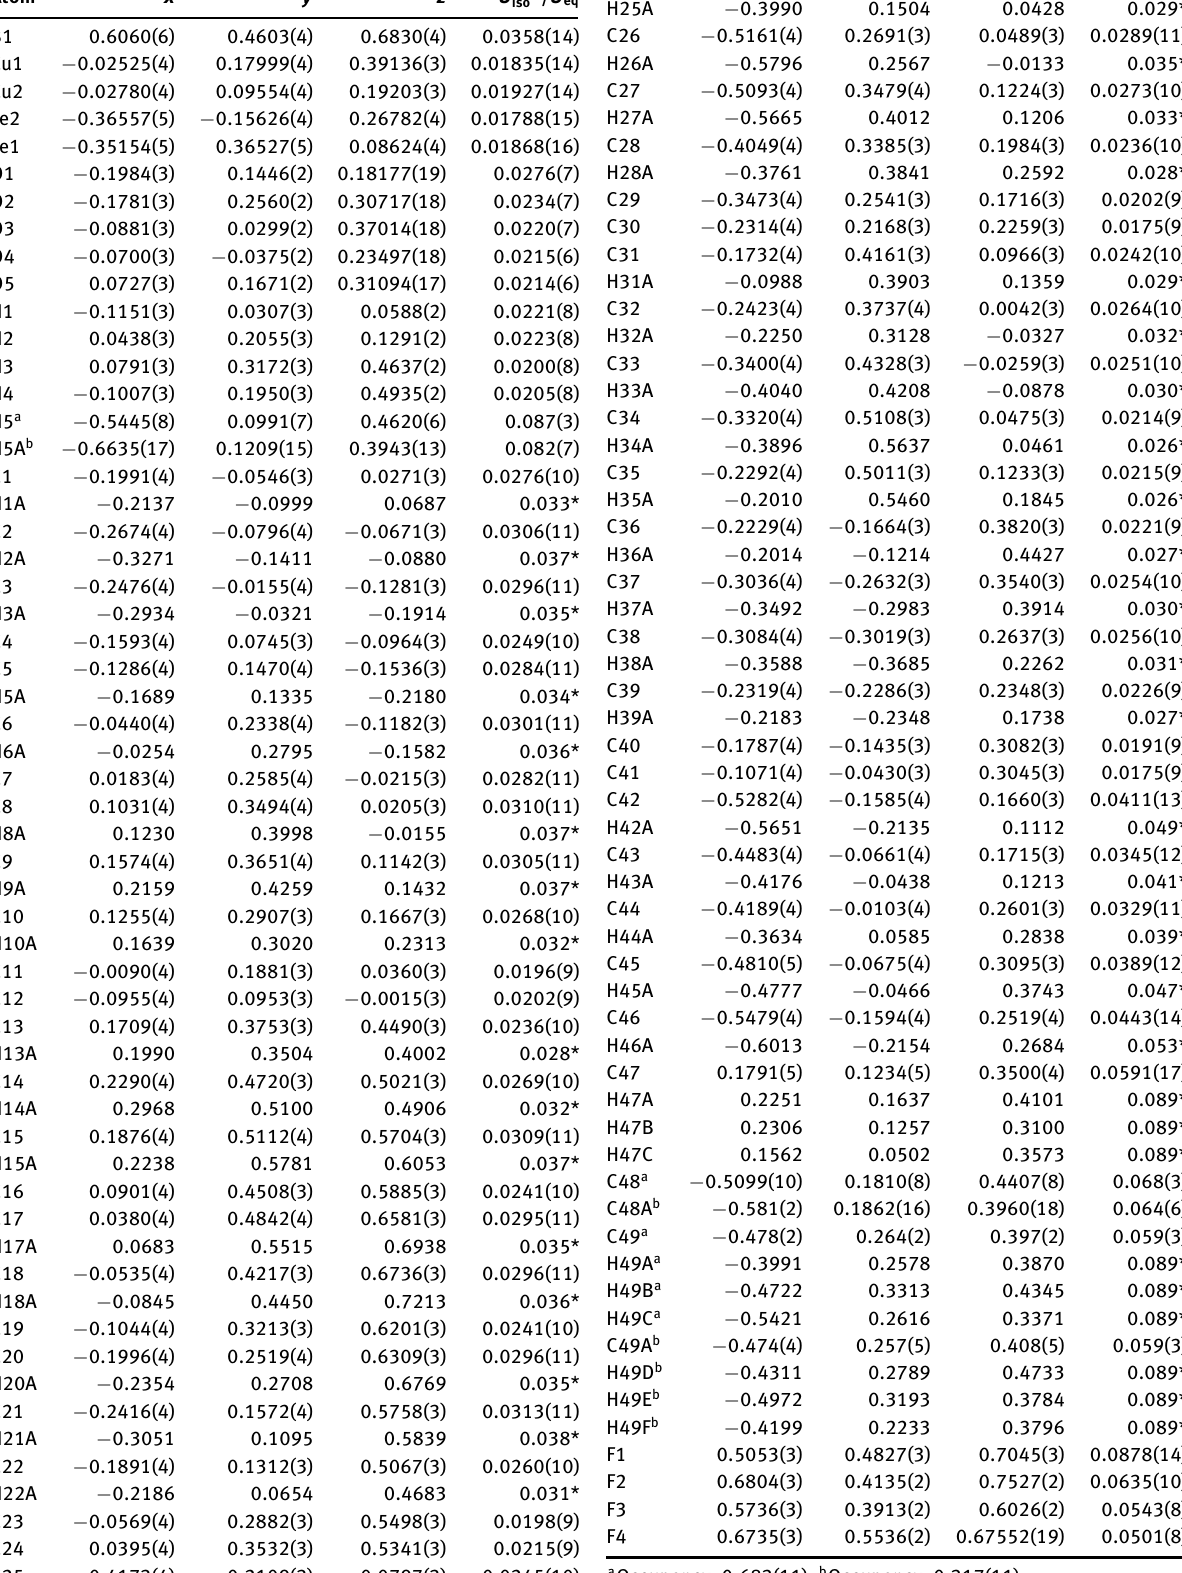
Table 2: Fractional atomic coordinates and isotropic or equivalent isotropic displacement parameters (Å 2